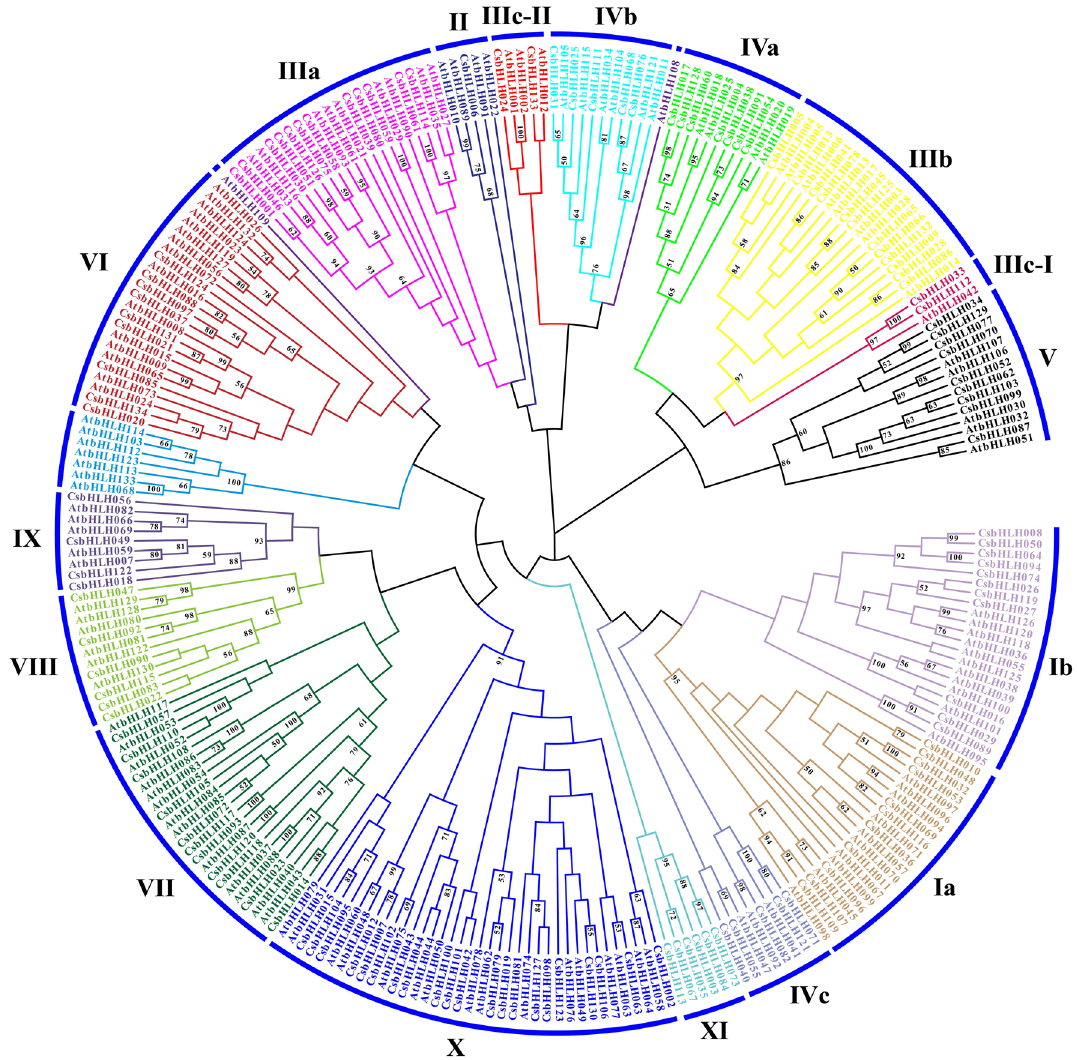
Figure 2. Phylogenetic tree analysis of tea plant and Arabidopsis thaliana bHLH proteins. Differently colored branches indicate different subgroups. The black Roman numerals indicate the subgroup name of each branch. Two branches did not include CsbHLH members, and they were not included in the